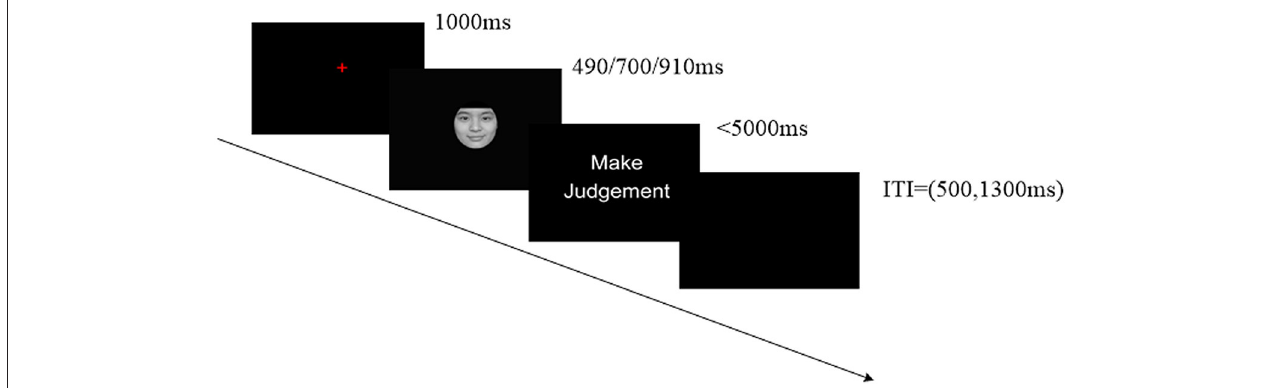
FIGURE 1 | Example of one trial in the test phase. Participants were asked to focus on the crosshairs for 1,000ms before being presented with a stimulus for 490, 700, or 910ms; they were then asked to make a judgment within 5,000ms. Individual trials were separated by a 500 or 1,300ms intertrial interval (ITI). We recorded EEG data for the emotional stimulus presentation during the test phase. Human images reproduced from Chinese Facial Affective Picture System (CFAPS) with